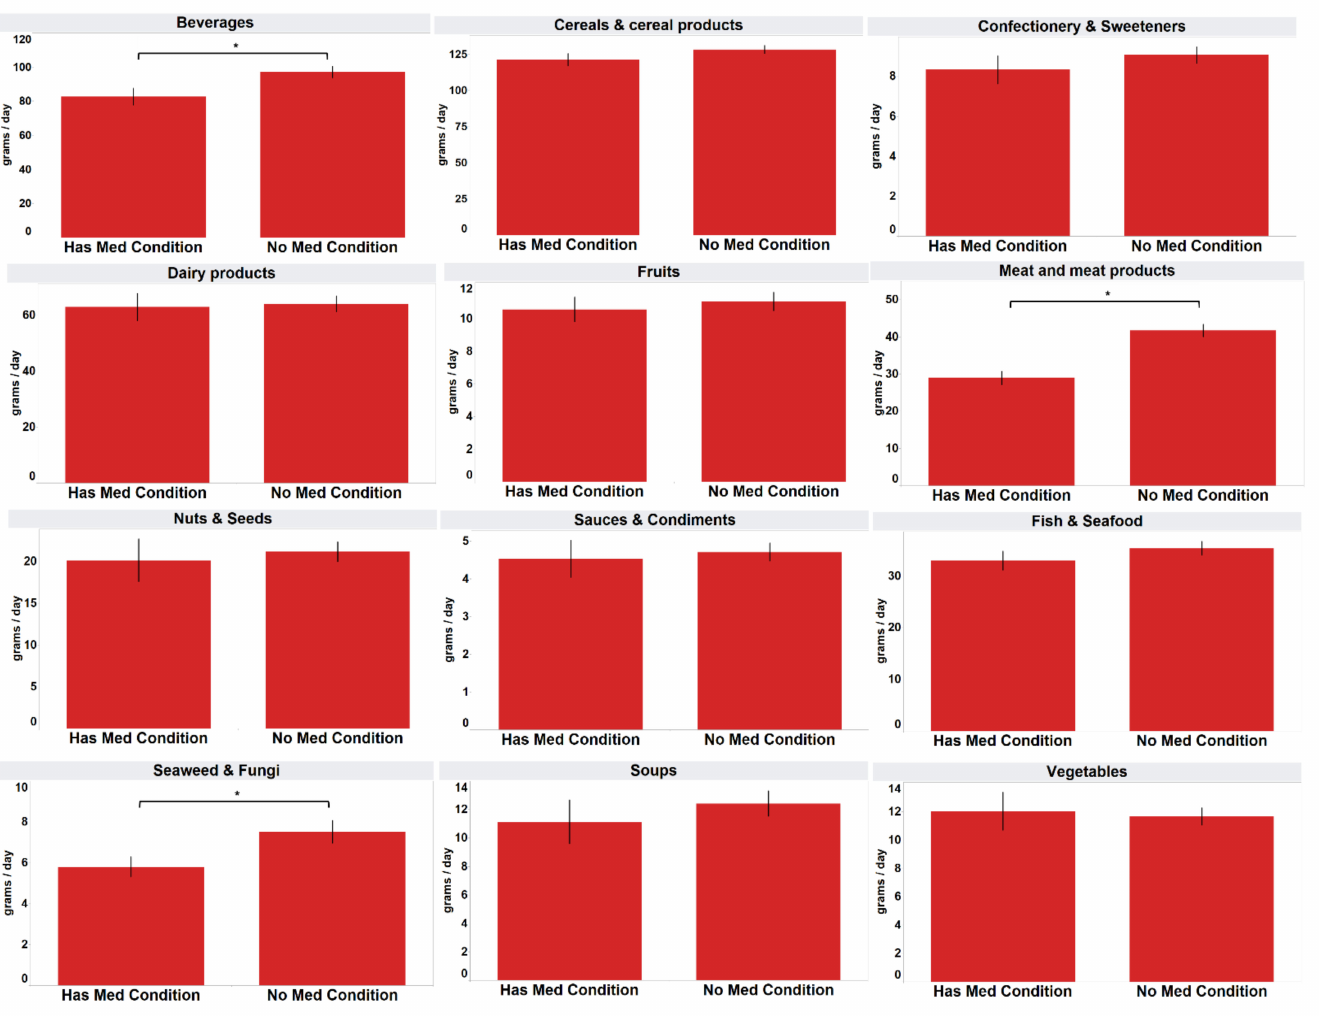
Figure 5. Mean daily intake of consumers analysed by self-reported health conditions. * Mean values were significantly different as determined by independent t -test ( p < 0.05). ‘Has Med Condition’ refers to having at least one health condition such as diabetes, high blood pressure or high cholesterol. Table 3. Processed food variety score by sociodemographic